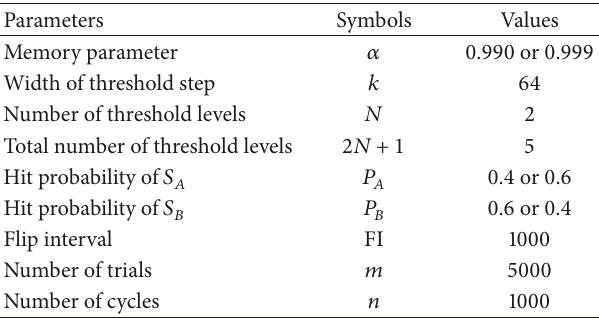
Figure2:Experimentalsetupfortheacquisitionofchaotictemporal waveforms in the semiconductor laser with optical feedback. ATT, variable attenuator; FC, fiber coupler; ISO, optical isolator; PD, photodetector.